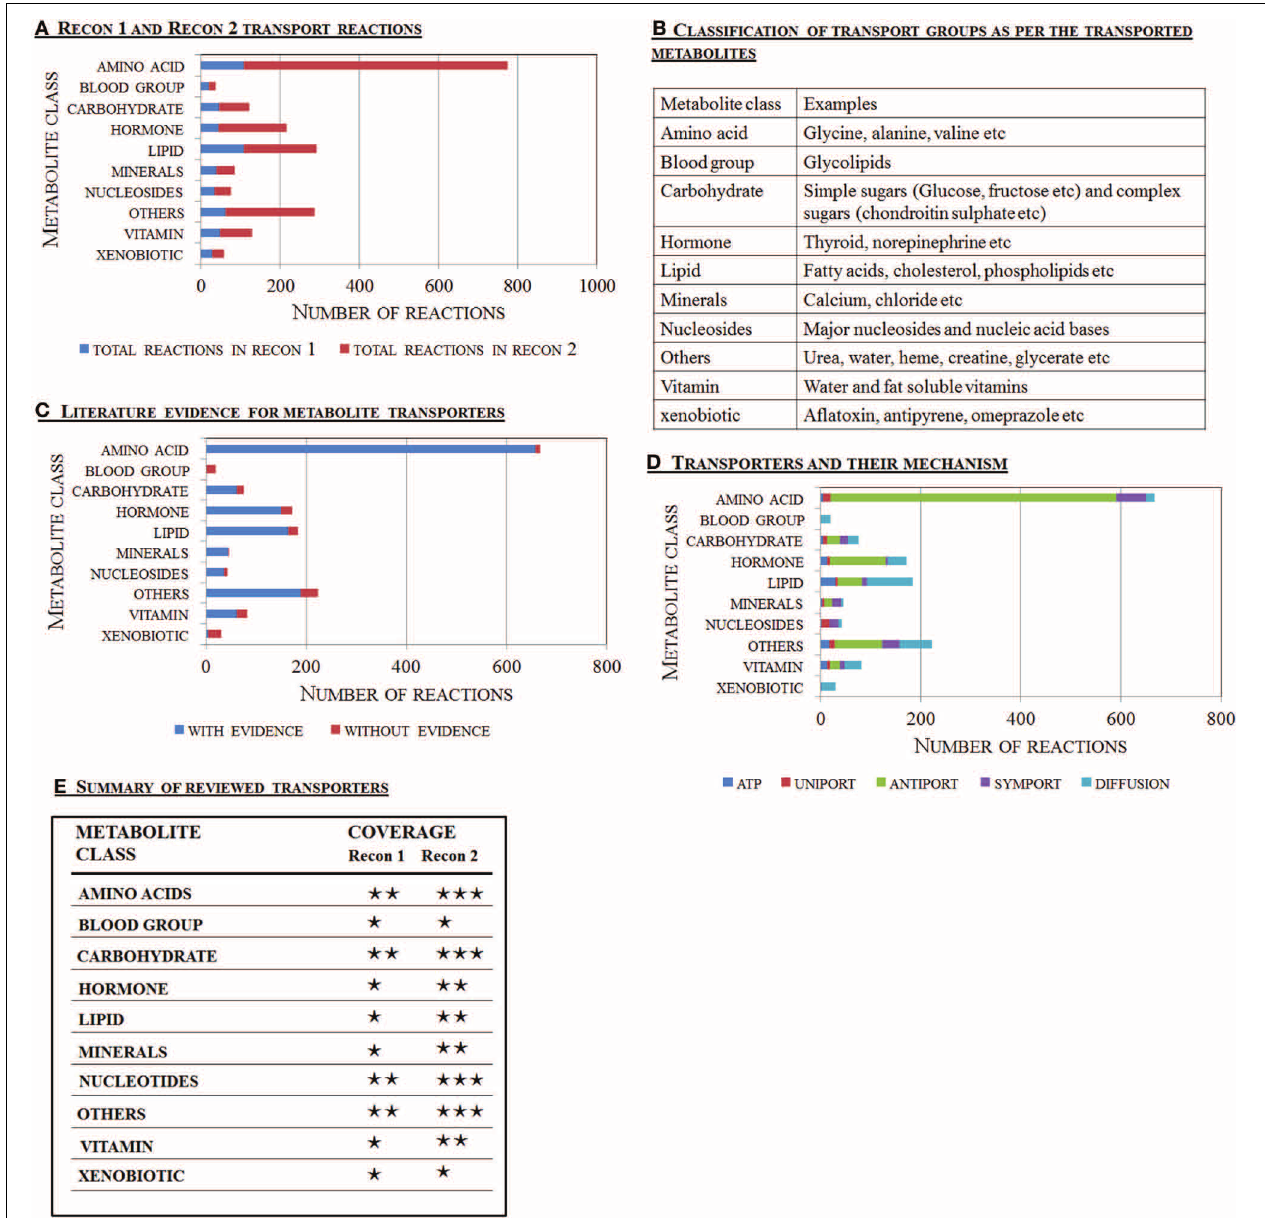
FIGURE 2 | Overview of transport reactions captured in the human metabolic reconstructions. The transporter content for the major metabolite classes captured by Recon 2 and Recon 1 are shown and compared. (A) Quantitative assessment of the transport reactions present in Recon 1 (Duarte et al., 2007) and Recon 2 (Thiele et al., 2013). (B) Classification of the transport reactions as per the major class of metabolite transported. (C) Literature support for the transport reactions present in Recon 2. (D) The metabolites were divided into ten metabolite